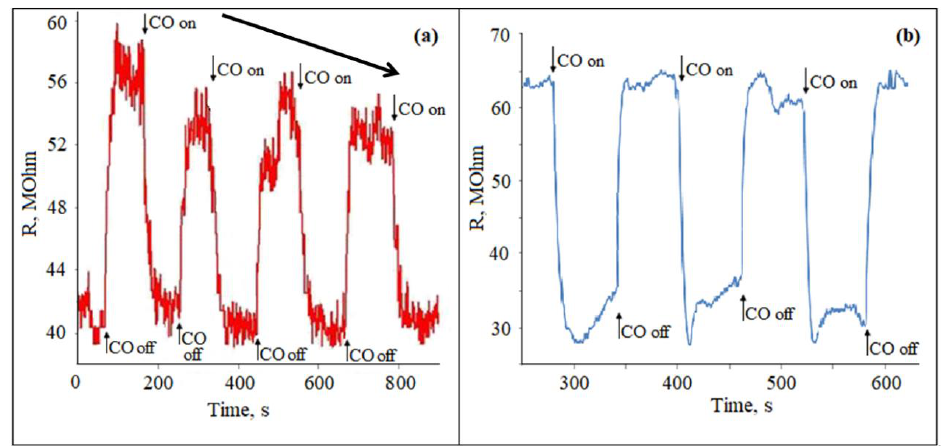
Figure 4. Poisoning effect of the ZTO films surface with the Zn:Sn ratio of 95:5 grown on the glass ( a ) and polycor ( b ) substrates when exposed to CO with a concentration of 50 ppm at 300 °C.